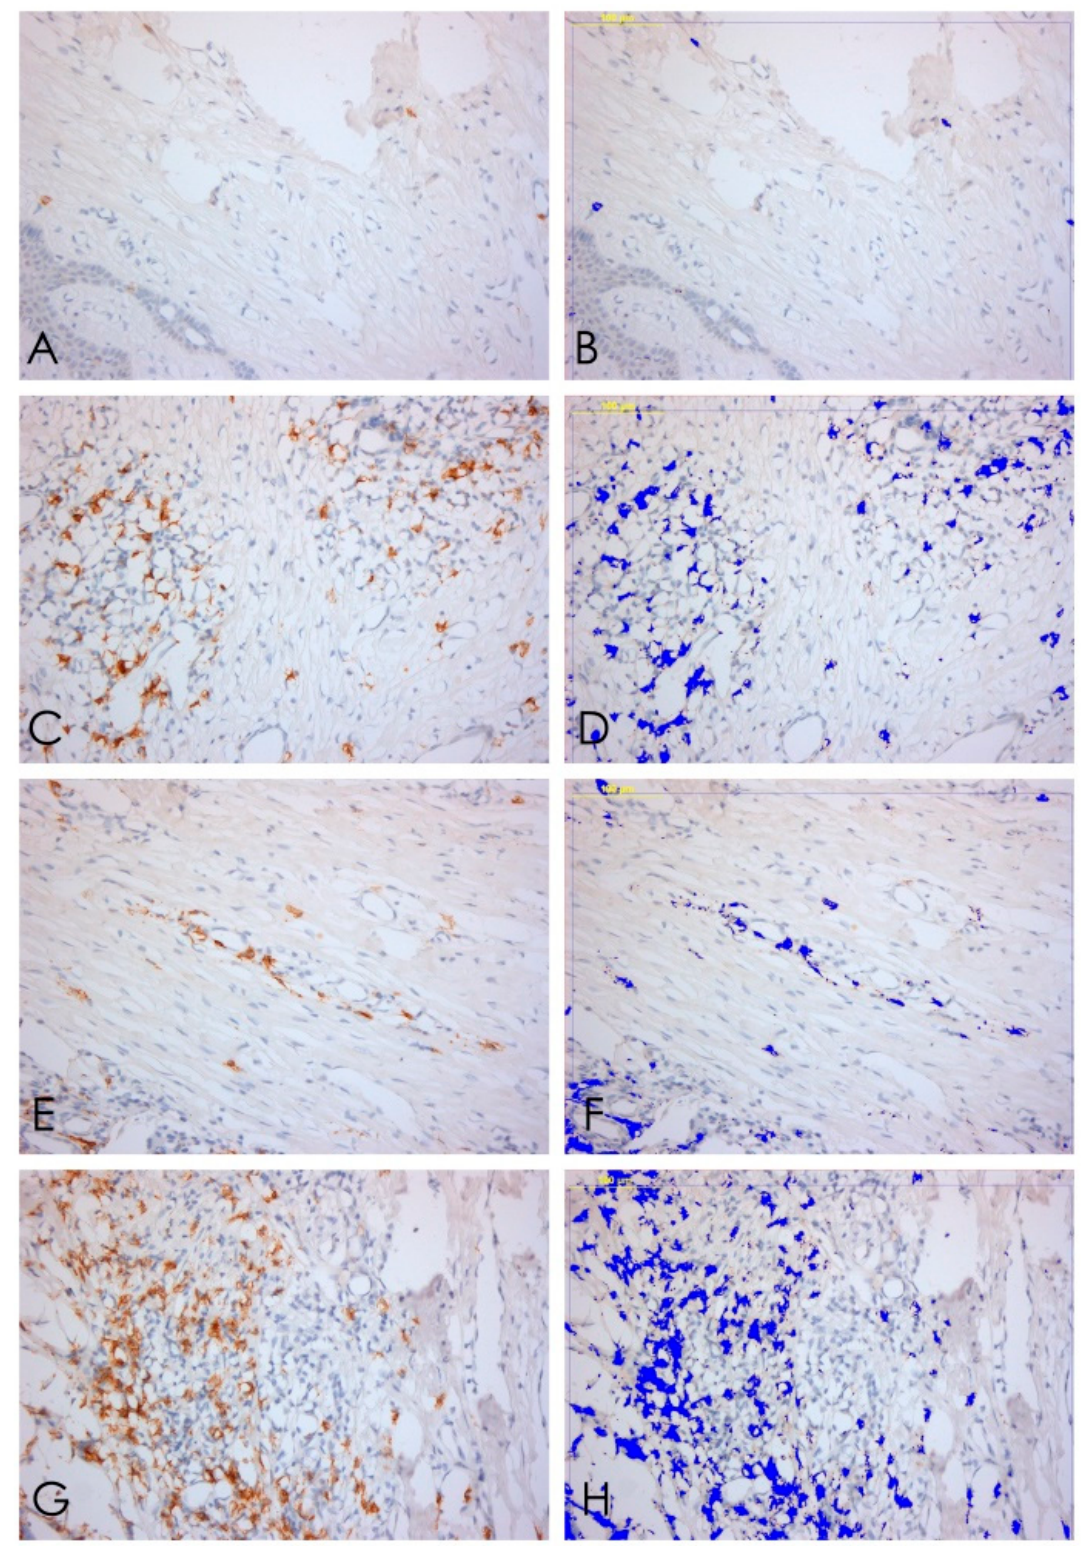
Figure 5. CD20. ( A , B ) B lymphocytes expression T1, 20 × ABC, and software analysis; ( C , D ) B lymphocytes expression T2, 20 × ABC, and software analysis; ( E , F ) B lymphocytes expression T3, 20 × ABC, and software analysis; ( G , H ) B lymphocytes expression T4, 20 × ABC; and software analysis.